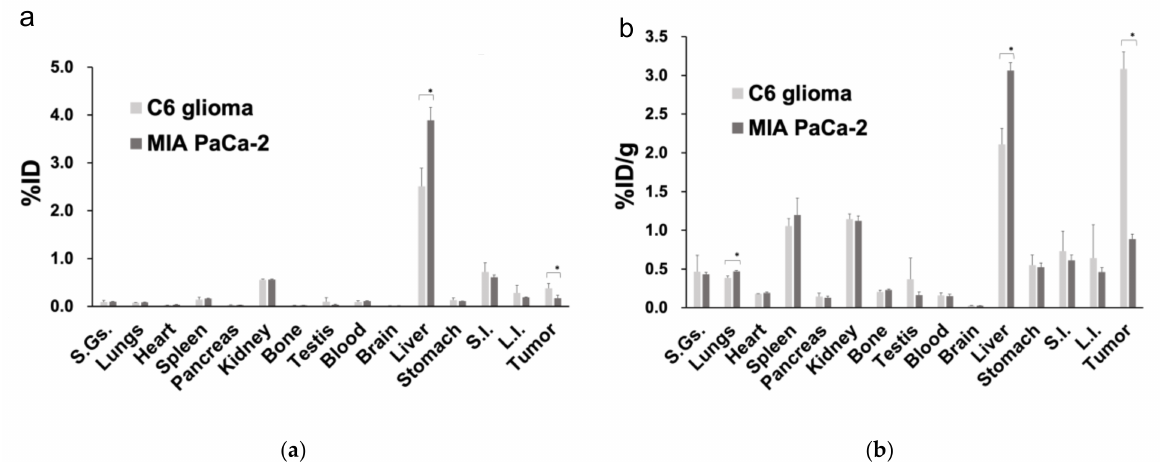
Figure 4. Biodistribution analysis comparing the percentage accumulation of the [ 68 Ga]Ga-DOTA-c(RGDfK) peptide based on ( a ) the injected dose and ( b ) the ratio of the injected dose to the weight of each organ (*: p < 0.05 as determined by an unpaired t -test). Abbreviations: %ID, percentage of the injected dose; %ID/g, ratio of the percentage of the injected dose over the weight of each organ; S.Gs.: salivary glands; S.I.: small intestine; L.I.: large